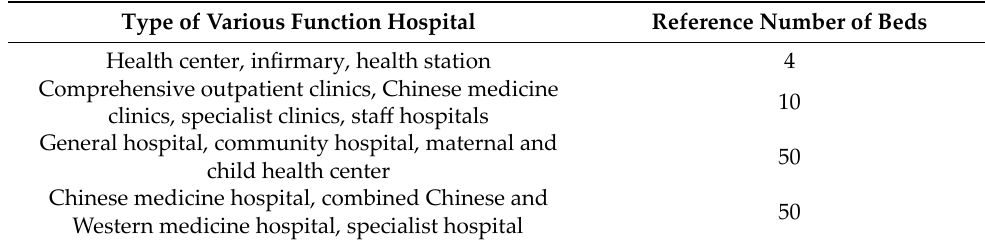
Table 2. Reference standard for the number of beds in various function